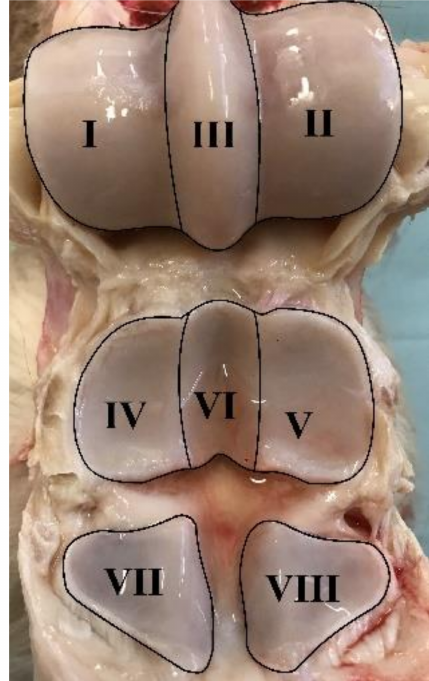
Figure 1. Regions defined in the metacarpophalangeal / metatarsophalangeal